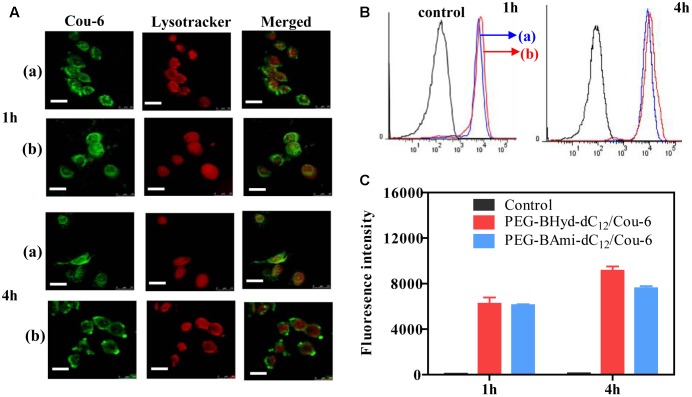
Cellular uptake studies of PEG-BHyd-dC12/Cou-6 and PEG-BAmi-dC12/Cou-6 in A549 cells by using CLSM (A), flow cytometry (B), fluorescence intensities quantified from B
(C). The (a) indicated PEG-BAmi-dC12/Cou-6 while the (b) represented PEG-BHyd-dC12/Cou-6. The scale bar is 25 μm.